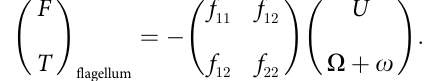
relatively to the fluid O + ω . This may be written as ! F : ð 1 Þ O þ o Prokaryotic flagellar filaments are very thin, with typical radii of 0.02 μ m and average lengths a thousand times greater (the mean value of all lengths in our database is h L i = 8.28 can be evaluated using the resistive- μ m), so that the coefficients of the symmetric matrix f ij